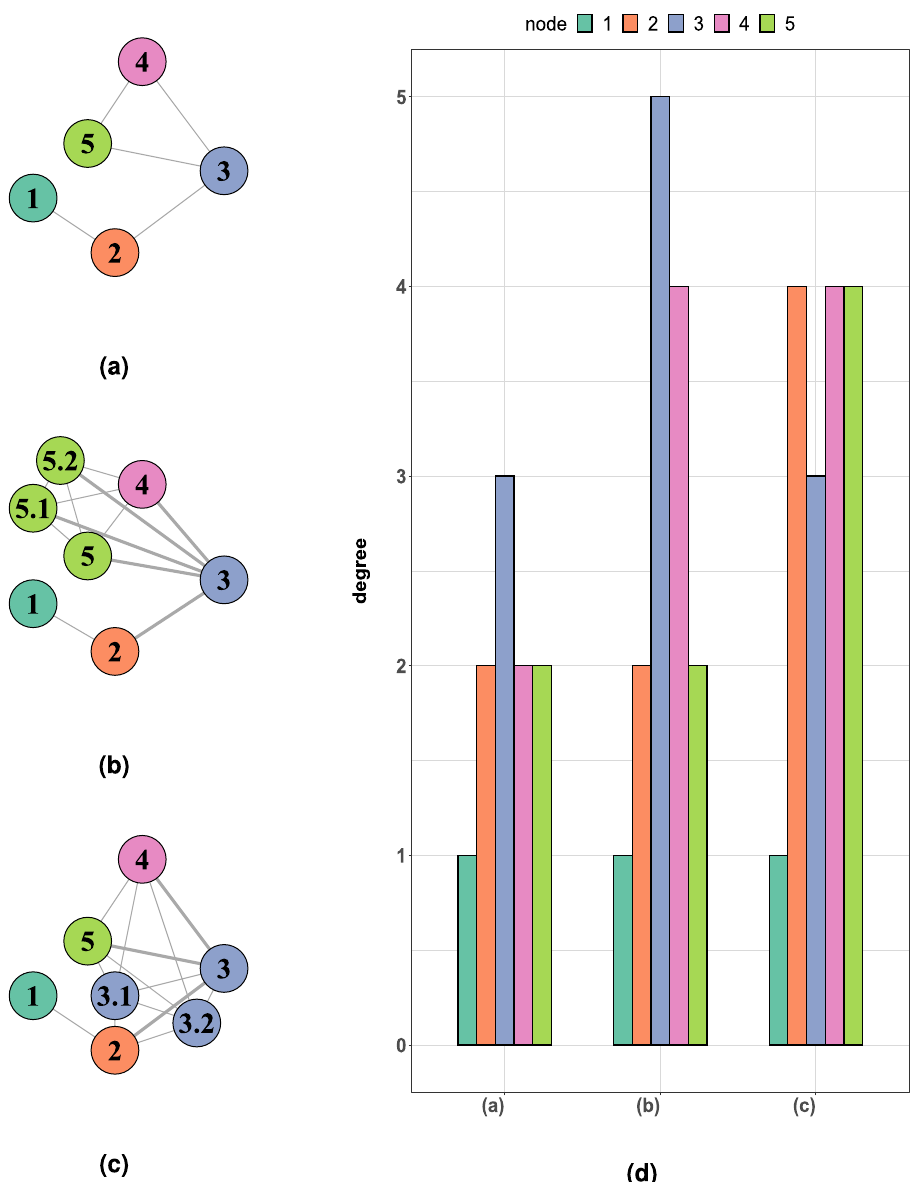
Figure 2. Same network, different WNNets. Once the master network was constructed (a) , two copies of master node 5, i.e. two new, green copies, were added. Then, these copies were connected with each other and with their master node to obtain a WNNet (b) . The same procedure was performed to model master node 3 and obtain a different WNNet (c) . Then, all the networks were analysed using degree. The bar plots (d) show the degree each master node scored in the master network and each of the two WNNets. The colour of each bar reflects the colour of the corresponding master node, and its copies, in the corresponding network. The length of the bar represents the master node